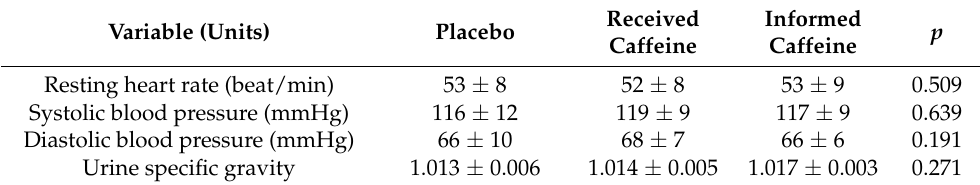
Table 1. Variables obtained at test in individuals who ingested (1) a placebo; (2) three mg of caffeine per kg of body mass (received caffeine); and (3) a placebo, but they were told they were given three mg of caffeine per kg mass (informed caffeine).